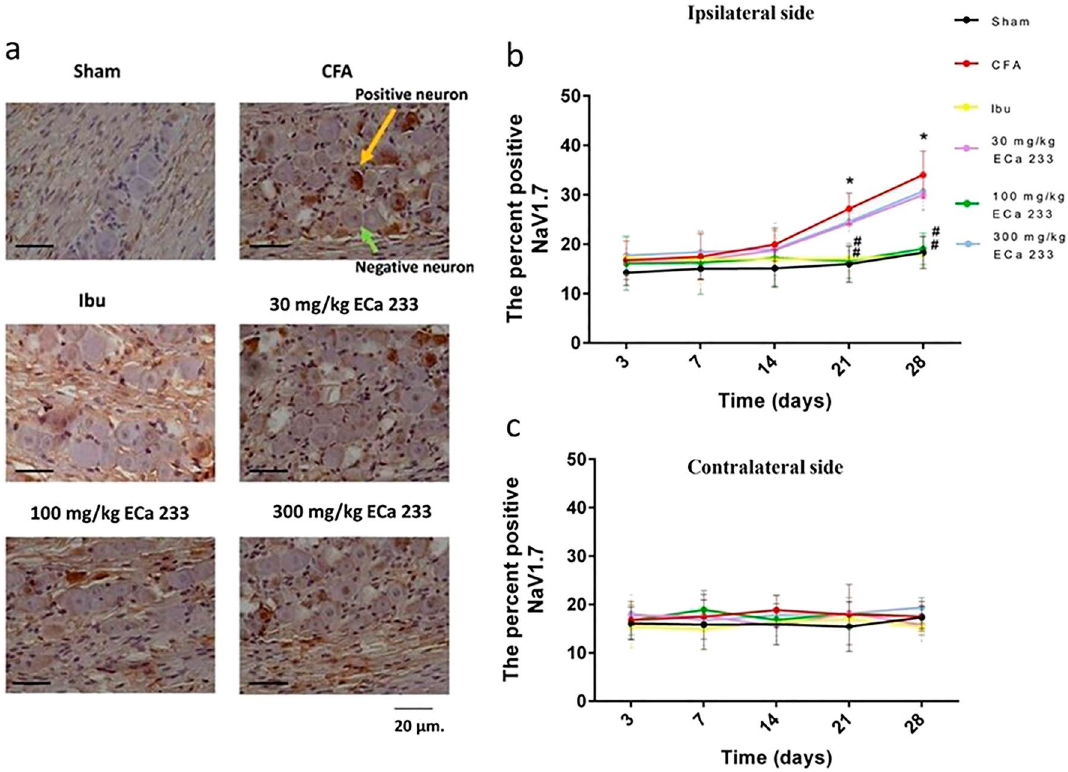
Figure 5. Voltage-gated sodium ion channel 1.7 (NaV1.7) expression in TGs in all groups at different time points. ( a ) An example of NaV1.7 staining by immunohistochemistry at the ipsilateral TG at post–CFA- injection day 28, scale bar = 20 µm. ( b , c ) Percentage of positive NaV1.7 neurons per total number of neurons in different groups. At post–CFA-injection days 21 and 28 in the ipsilateral TG, the NaV1.7 expression in the complete Freund’s adjuvant–treated (CFA) group increased compared with that in the Sham group (day 21 [F(5,48) = 9.463, P < 0.05], day 28 [F(5,48) = 8.633, P < 0.05]), whereas that in the groups treated with ibuprofen and 100 mg/kg ECa 233 (Ibu and 100ECa groups, respectively) significantly decreased (day 21: Ibu [F(5,48) = 10.521, P < 0.05], 100ECa [F(5,48) = 12.545, P < 0.05]; day 28: Ibu [F(5,48) = 9.452, P < 0.05], 100ECa [F(5,48) = 10.985, P < 0.05]) compared with that in the CFA group. Both 30ECa and 300ECa showed no difference from the CFA group (day 21: 30ECa [F(5,48) = 5.9372, P = 0.183], 300ECa [F(5,48) = 6.937, P = 0.192]; day 28: 30ECa [F(5,48) = 5.342, P = 0.173], 300ECa [F(5,48) = 6.937, P = 0.192]). In the contralateral TG, CFA did not change the NaV1.7 expression (day 21 [F(5,48) = 1.925, P = 0.132], day 28 [F(5,48) = 1.895, P = 0.113]) (mean ± SEM; n = 3/groups at each time point; *P < 0.05 compared with the Sham group, # P < 0.05